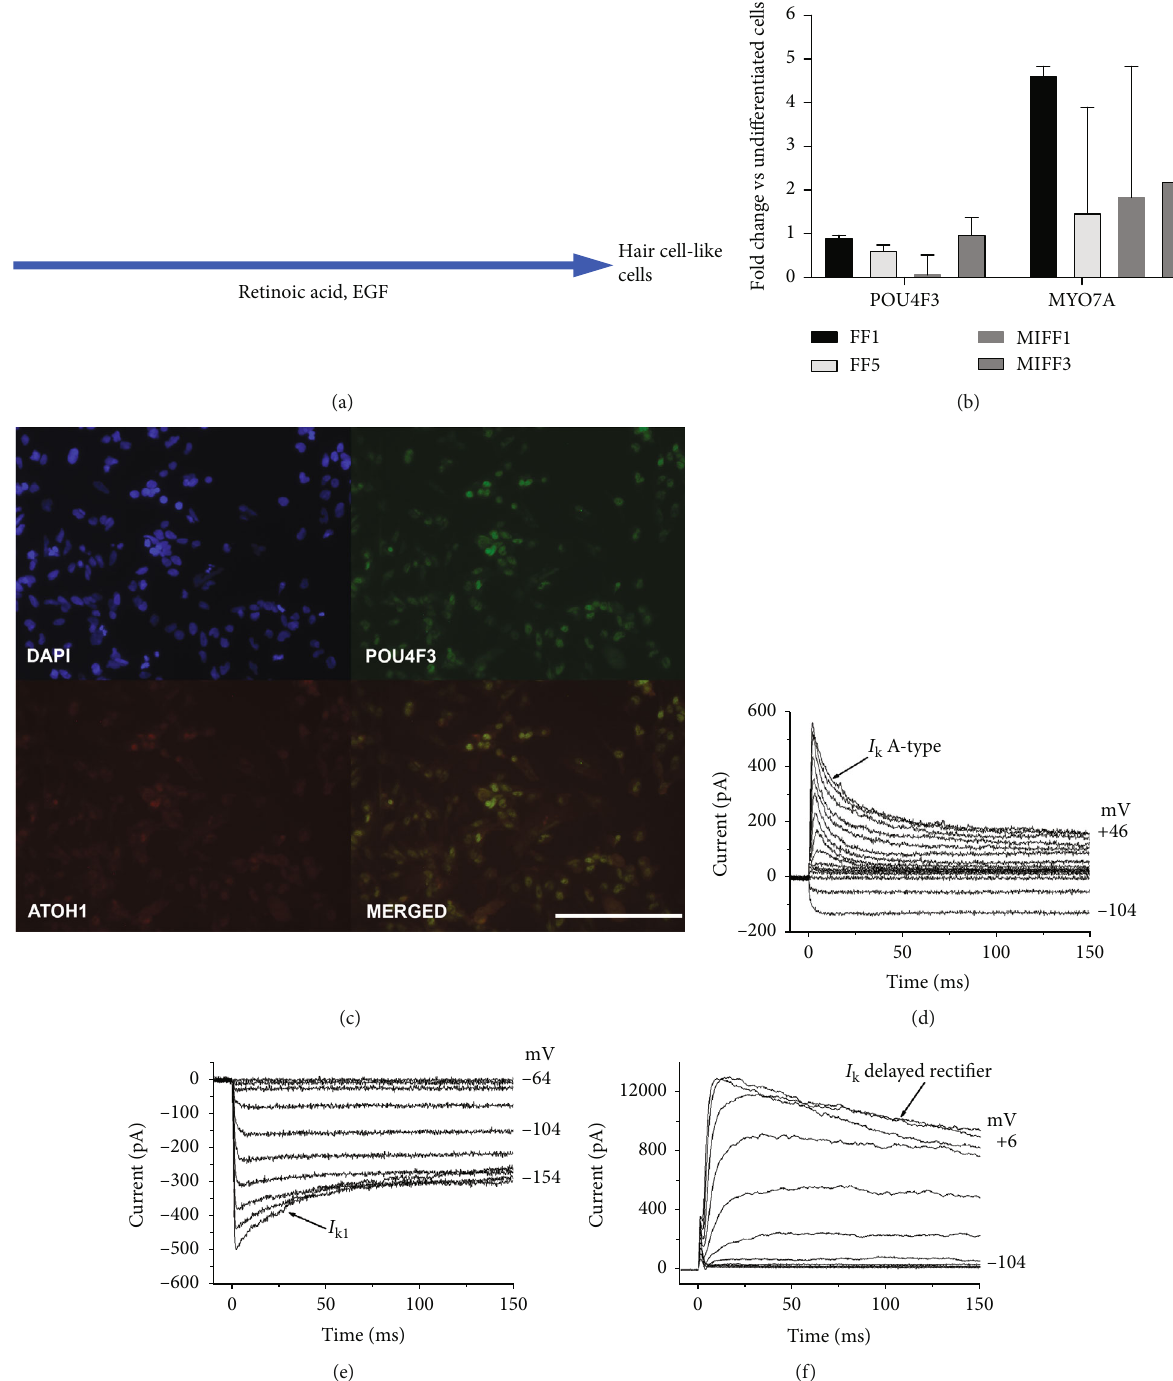
Figure 3: (a) Diagram showing the protocol for the generation of hair cell-like cells. (b) qPCR showing relative expression levels of the hair cell markers POU4F3 and MYO7A. Data shown as fold change against undi ff erentiated cells from the same initial population. (c) ATOH1 and POU4F3 proteins are coexpressed by some cells. Immuno fl uorescence images shown are from cell line MIFF1. Scale bar, 200 μ m (d). Electrophysiological properties of di ff erentiating hair cell-like cells. To investigate the presence of outward and inward K + currents, cells were recorded using the same voltage protocol described in Figure 2. Outward K + currents were observed in 10 out of 12 hair cell-like cells; these currents were either an inactivating A-type K + current ( 266 ± 62 pA at 0 mV, n = 7 out of 10 cells (d)) or a delayed recti fi er current ( 476 ± 174 pA at 0 mV, n = 3 out of 10 cells (f)). Inward K + currents ( I K1 : − 307 ± 79 pA near -124 mV) were observed in 4 out of 12 hair cell-like cells ((e) holding potential -64 mV, same as the cell in